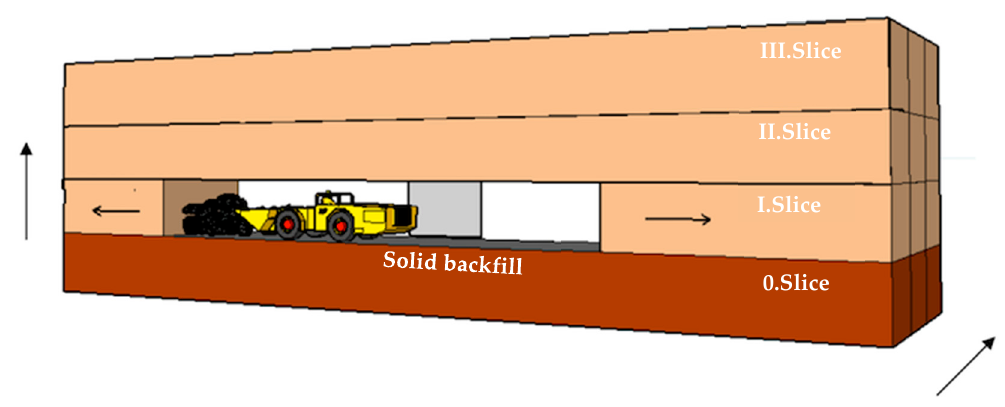
Figure 6. The procedure of excavating inside a mining block.